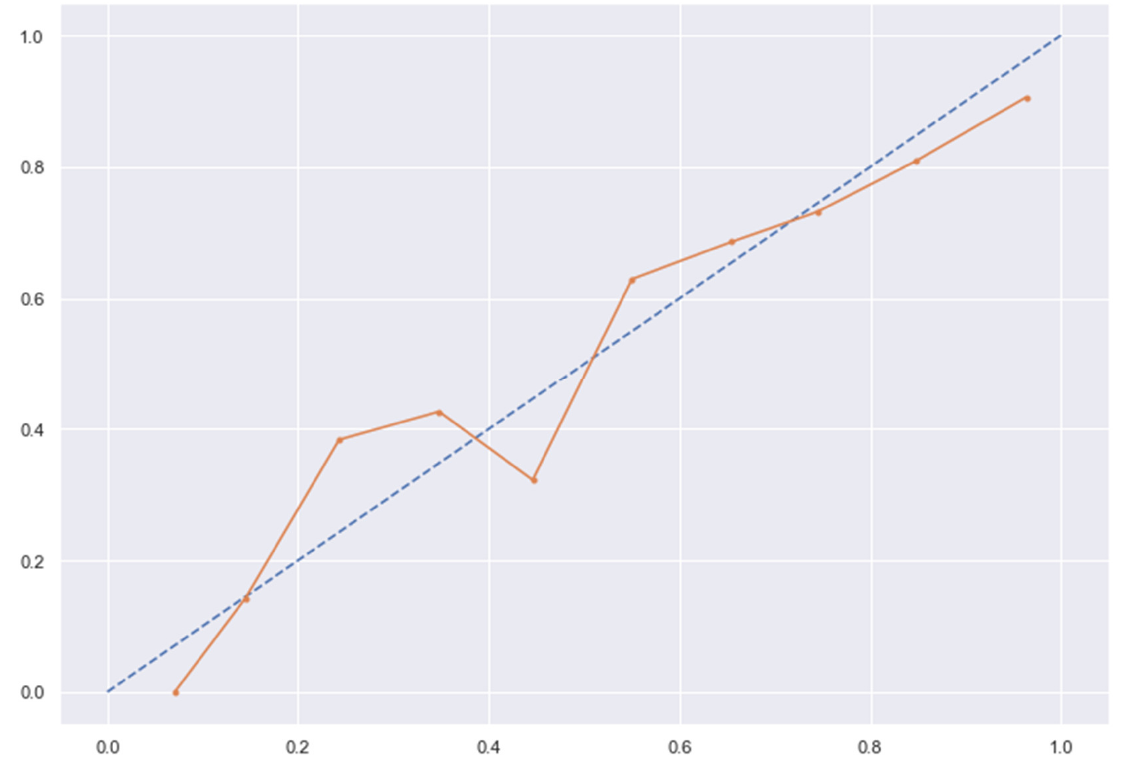
Figure 13. SVC line without calibration vs. after calibration (Ideal fit is represented as blue line).